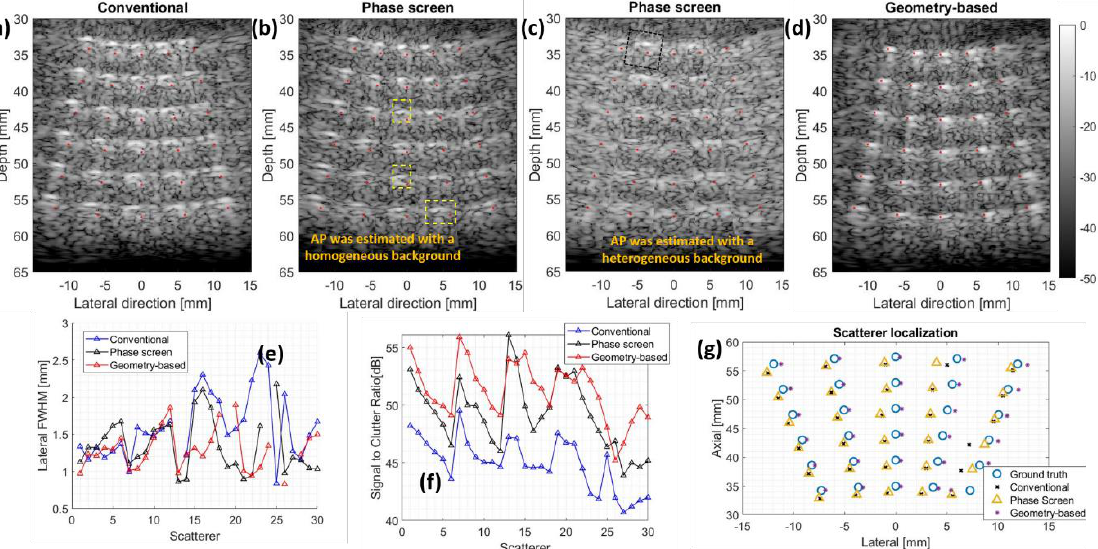
Figure 7 . The reconstructed numerical images using ( a ) conventional beamforming, ( b , c ) phase-screen modeling, and ( d ) geometry-based reconstruction techniques with a realistic bone model (Figure 3b, based on the micro CT of a real human temporal bone). The aberration profile was estimated using a dataset generated with a ( b ) homogeneous and ( c ) heterogeneous background wave-speed model. The red dots indicate the true location of the scatterers. The lateral FWHM ( e ), the signal-to-clutter ratio ( f ), and the localization error ( g ) obtained with all the methods for each scatterer.